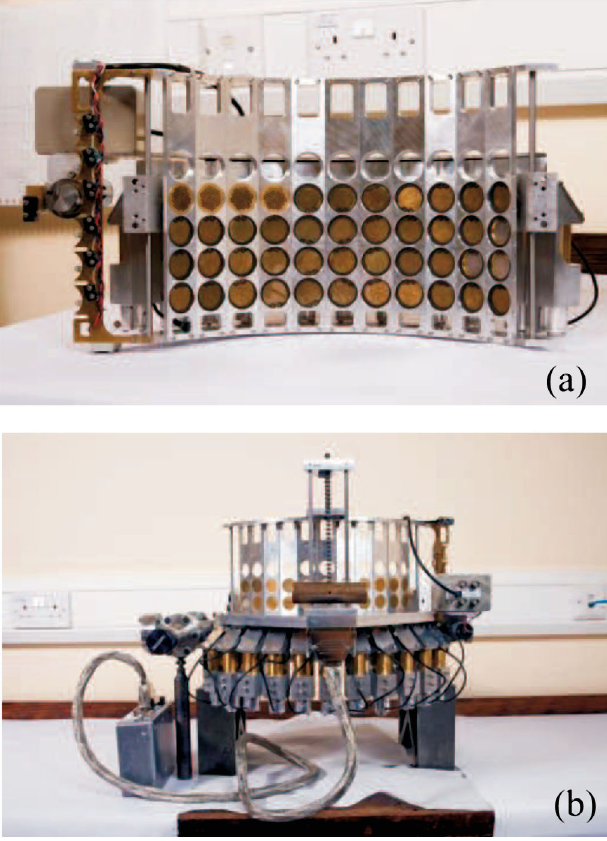
FIG. 3. (Color) (a) The filter changing mechanism and (b) the complete experimental apparatus. The box on the left is the DAQ